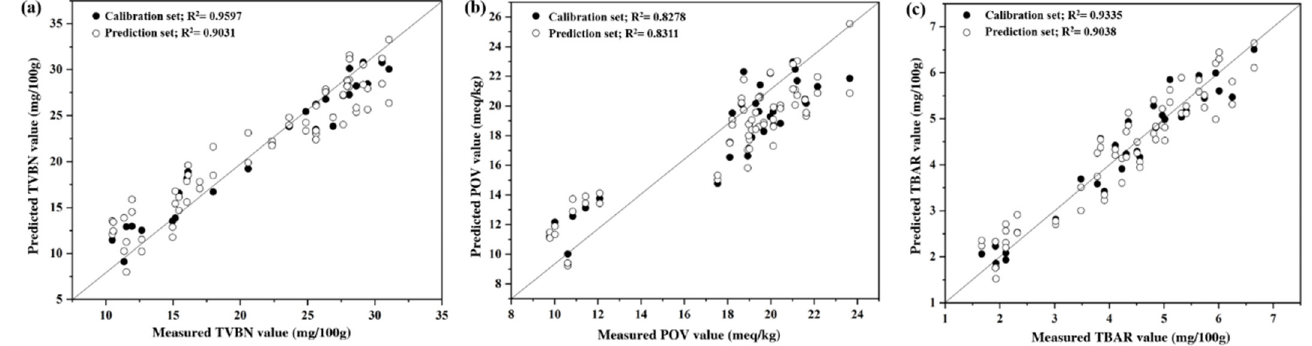
Figure 5. PLSR graph of correlation between CSA values and POV, ( a ); TVB-N, ( b ); TBA values, ( c ).